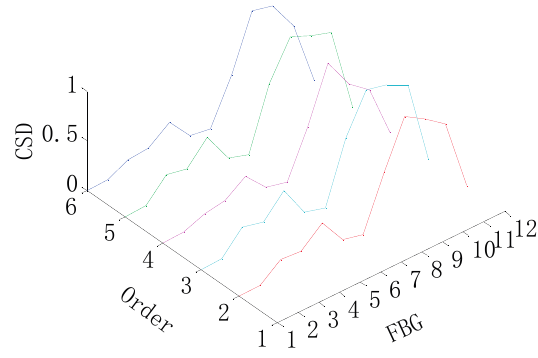
Figure 4. CSD for the single-damage detection.